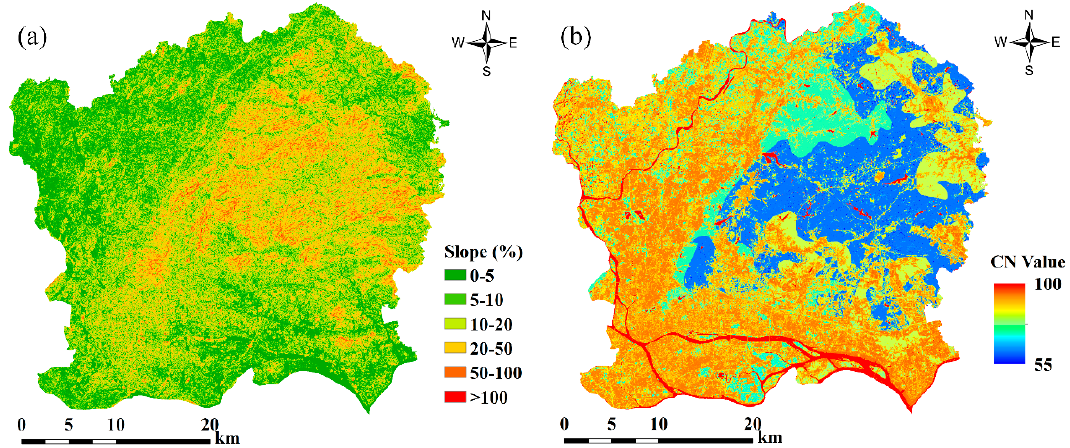
Figure 13. Slope map ( a ) and its adjusted CN map ( b ) under the AMC II condition .